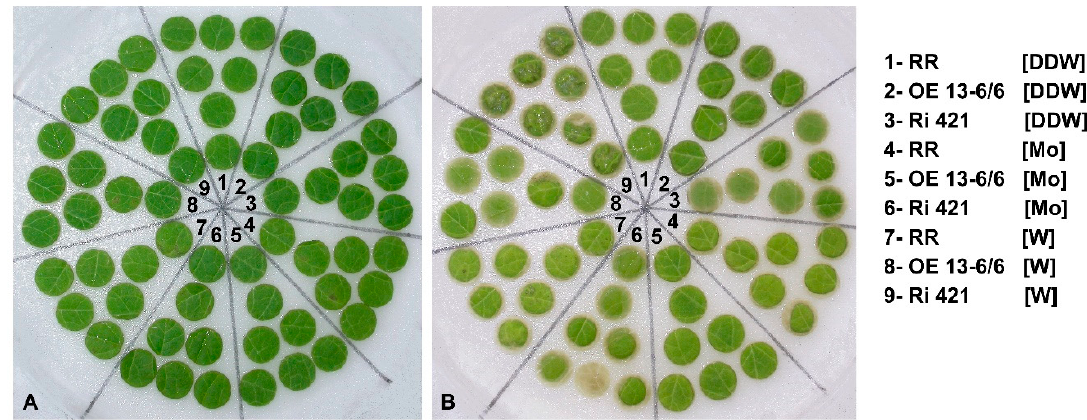
Figure 7. The response of molybdenum, tungsten and DDW pretreatments to toxic sulfite levels in wild type and SO modified tomato lines. Leaves from wild type (RR) and SO OE (OE 13-6 / 6) and SO Ri (Ri 421) tomato lines were incubated in DDW, 500 µ M Mo or 300 µ M W for 24 h, then leaf discs were subjected to ( A ) 0 mM and ( B ) 7 mM Na 2 SO 3 for 24 h and photographed.